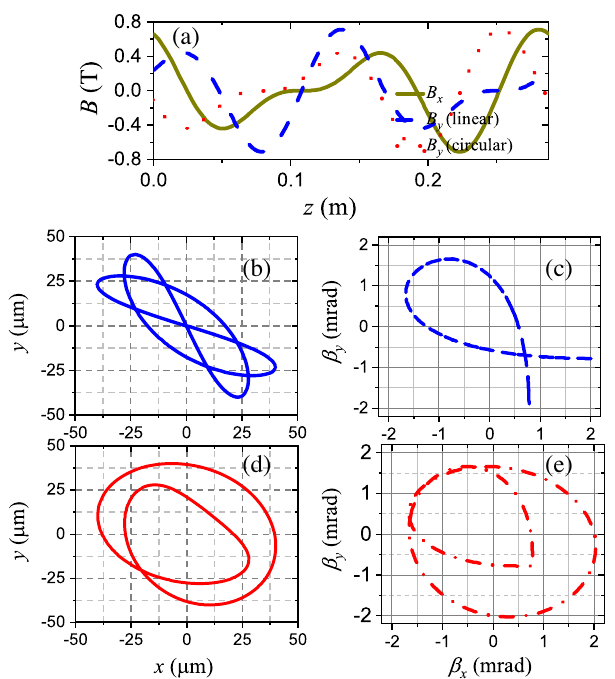
FIG. 8. The magnetic fields (a) of the linear and circular mode in the Knot AMPU, with the corresponding electron orbits (b), (d) and velocities (c), (e). The blue lines (b), (c) are corresponding to the 135° linear mode and the red lines (d), (e) are corresponding to the right-hand circular mode,